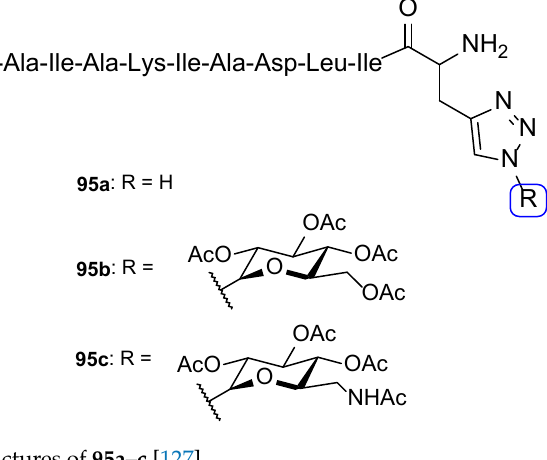
Figure 46. Chemical structures of 95a – c